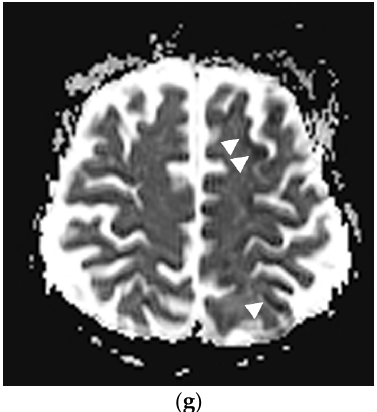
Figure 4. Following the placement of right internal jugular tunneled Hickman line, a 76 ‐ year ‐ old man developed an episode of desaturation, tachycardia, and non ‐ responsiveness. Subsequently, an immediate CT of brain, neck and chest was performed and gas was found in the left cavernous sinus ( a , b ) and within a left parietal sulcus ( c ); it was felt to represent air in a vessel, possibly a pial vein. There was also a large amount of air surrounding the right internal jugular vein ( d ); with a partially visualized central venous catheter (*). A brain MRI was performed showing FLAIR hyperintensity in multiple regions ( e ) with evidence of restricted diffusion ( f ); and corresponding low signal (arrowheads) on the apparent diffusion coefficient (ADC) images ( g ). The patient received a single treatment of hyperbaric oxygen but died 8 days later.